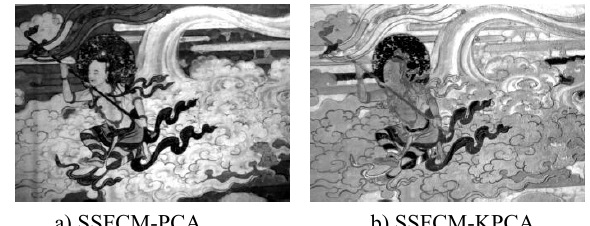
Figure 4 . Optimal Principal Component Images for Blocking